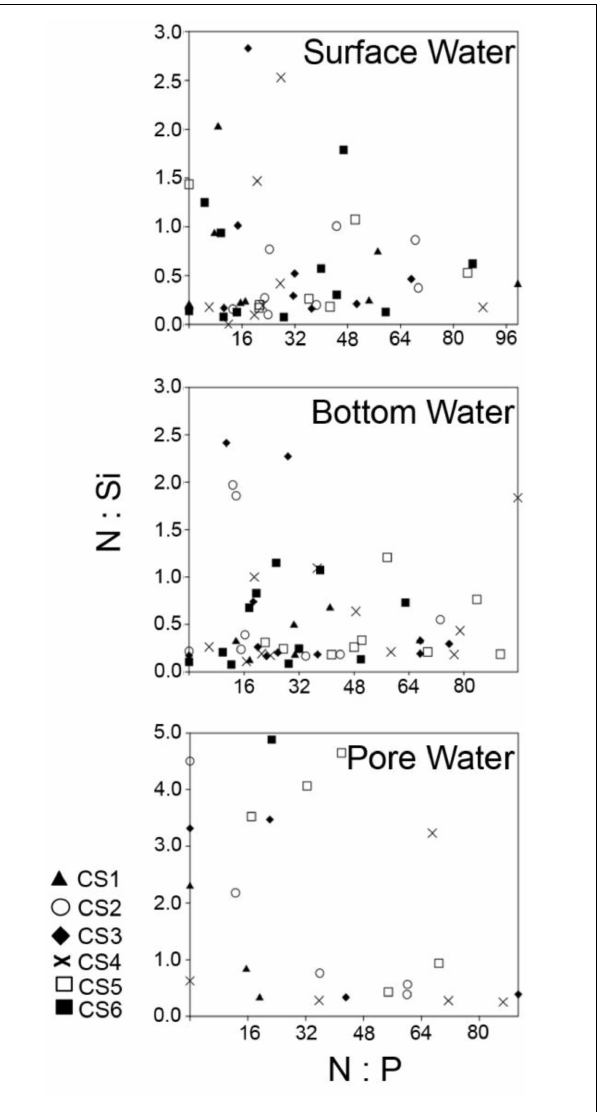
FIGURE 9 | Comparison of N:P and N:Si ratios from all the studied compartments across the sampling stations representing the study period. DIN was calculated by combining the values of dissolved NO 3 - and dissolved NH 4 + . Ratios from surface and bottom water fractions have been calculated by considering sample size of n = 72, while values from pore water fractions have been calculated by using, n =